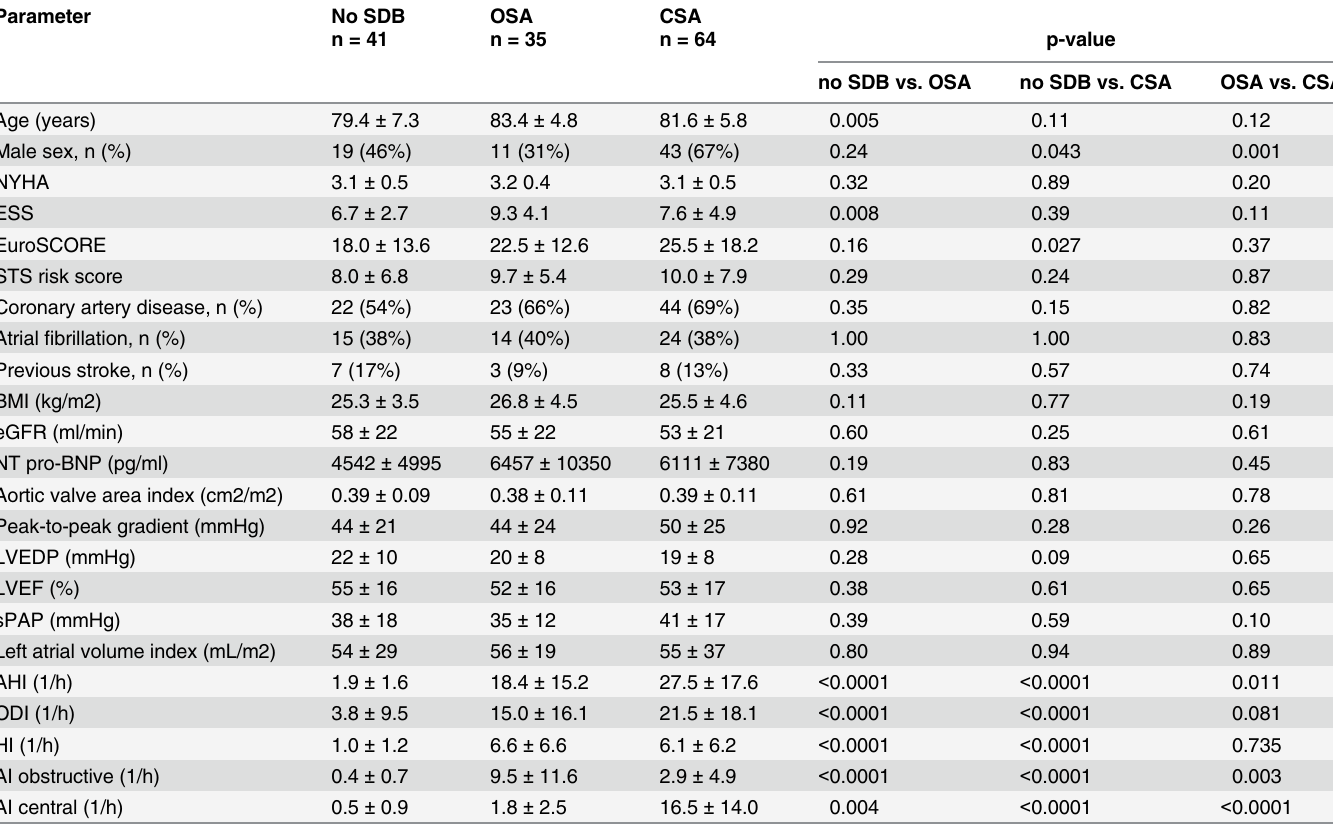
Table 2. Comparison of clinical and hemodynamic parameters between patients without SDB or with OSA or CSA.